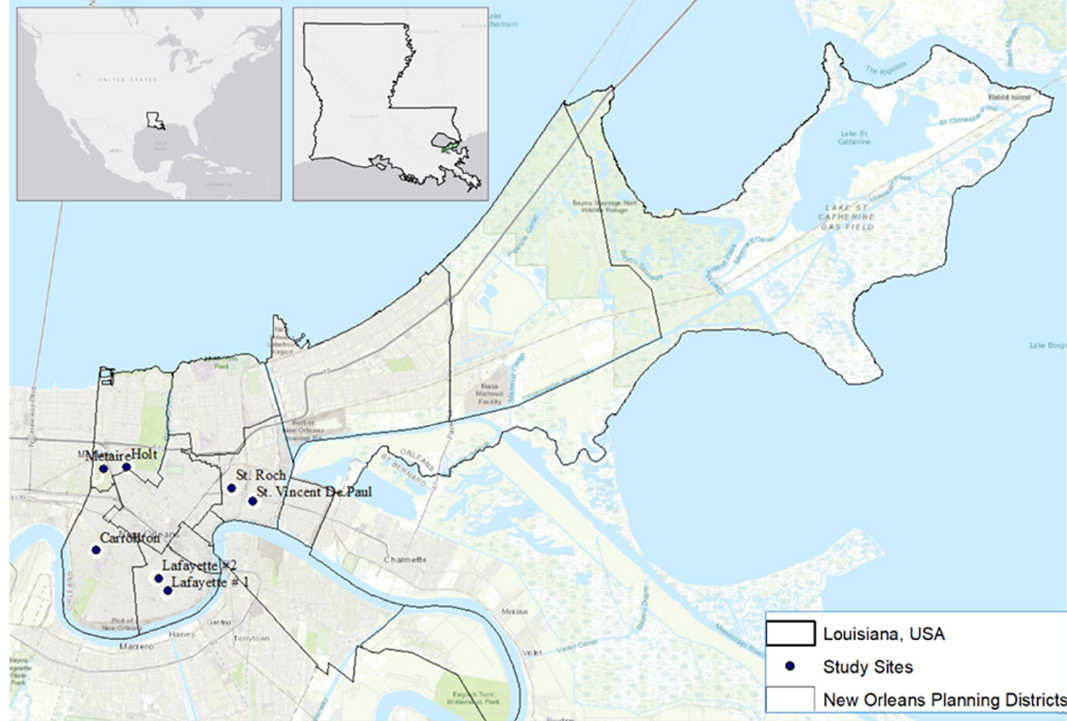
Figure 1. Study sites in the city of New Orleans, LA, located in the Southeastern USA. Topographic map source: Esri, Garmin, Intermap, increment P Corp., GEBCO, USGS, FAO, NPS, NRCAN, GeoBase, IGN, Kadaster NL, Ordnance Survey, Esri Japan, METI, Esri China (Hong Kong), OpenStreetMap contributors, and the GIS User Community.